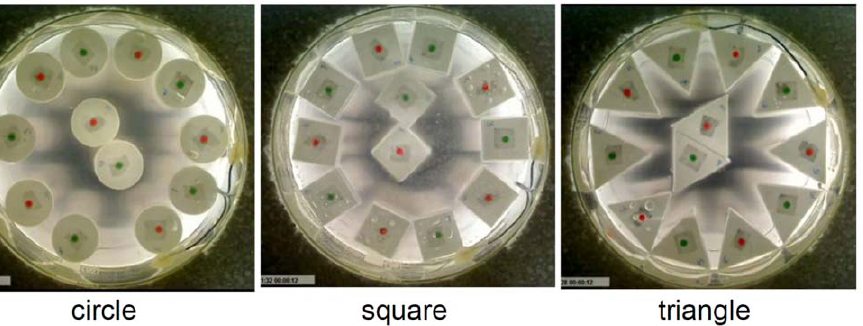
Figure 11. Initial configurations for the circular, square, and triangular cases. Note that the elements’ centers are colored red and green to indicate the active and passive elements,